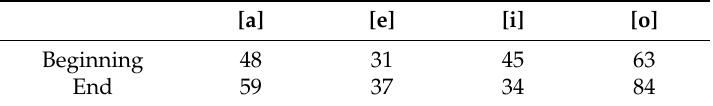
Table A15. Token counts for vowel formant measurements used to assess changes in individual vowel production by Informant E in Section